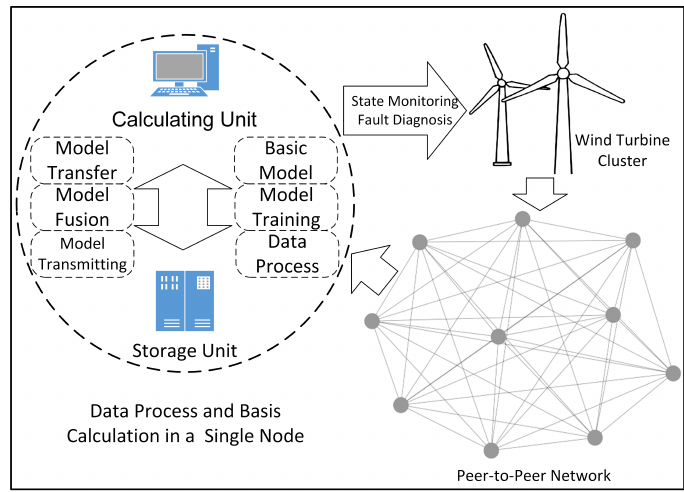
Figure 1. Fault diagnosis framework for wind turbine cluster based on a peer-to-peer